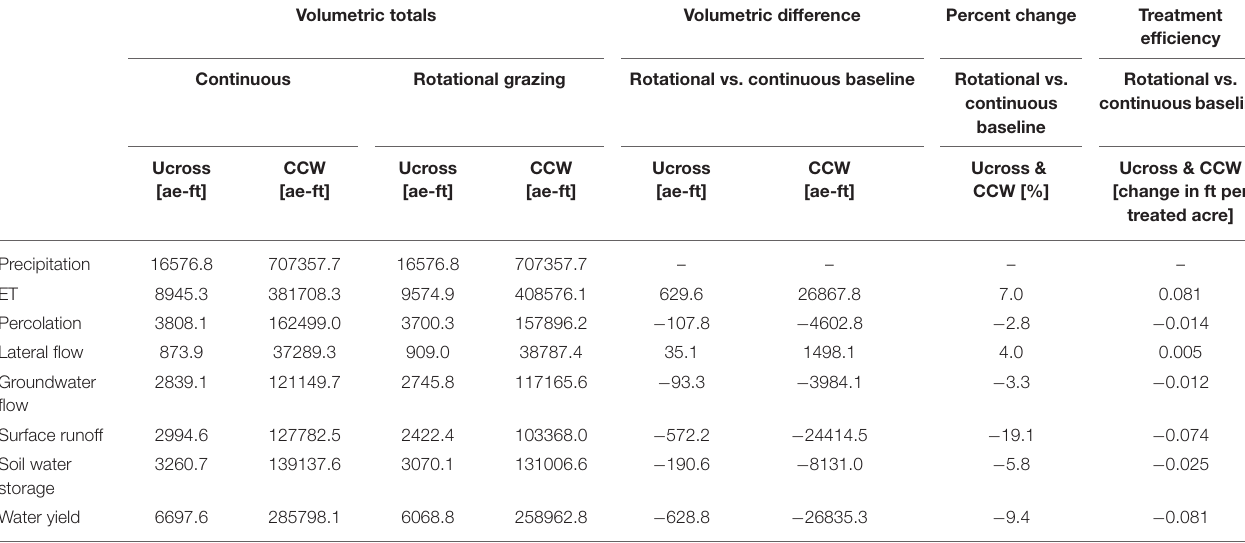
TABLE 4 | Volumetric totals and comparisons for water balance parameters throughout the season at the ranch and watershed scale. Volumetric totals Volumetric difference Percent change Treatment Continuous Rotational grazing Rotational vs. continuous baseline Rotational vs.